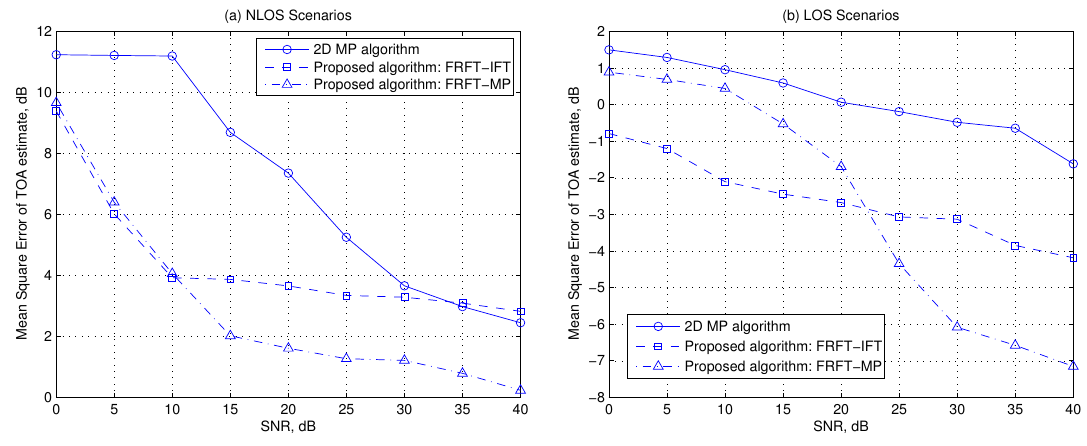
Figure 3. Mean square error versus SNR in NLOS scenarios and LOS scenarios, respectively.